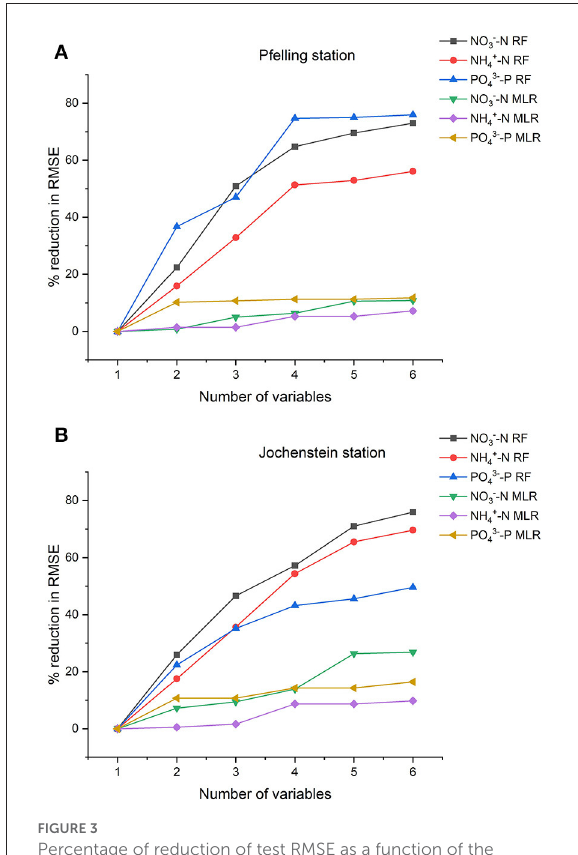
FIGURE3 Percentage of reduction of test RMSE as a function of the number of predictors in MLR and RF models in (A) Pfelling station and (B) Jochenstein station.